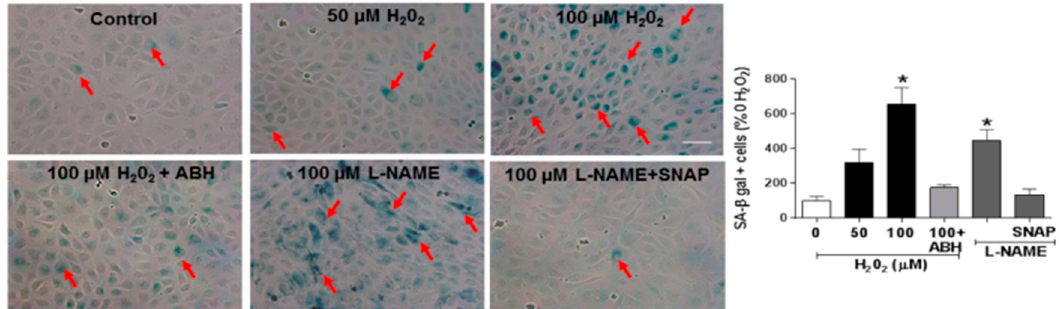
Figure 9. Hydrogen peroxide induces an increase in SA- β -gal activity. Treatment of retinal endothelial cells with hydrogen peroxide or the NOS inhibitor L -NG-nitroarginine methyl ester ( L -NAME) induced a significant increase in SA- β -gal activity (arrows). Treatment with the arginase inhibitor ABH blocked the hydrogen peroxide effect and treatment with the NO donor SNAP blocked the L-NAME effect. * p < 0.05 vs. control, n = 17. Scale bar = 30 µm.